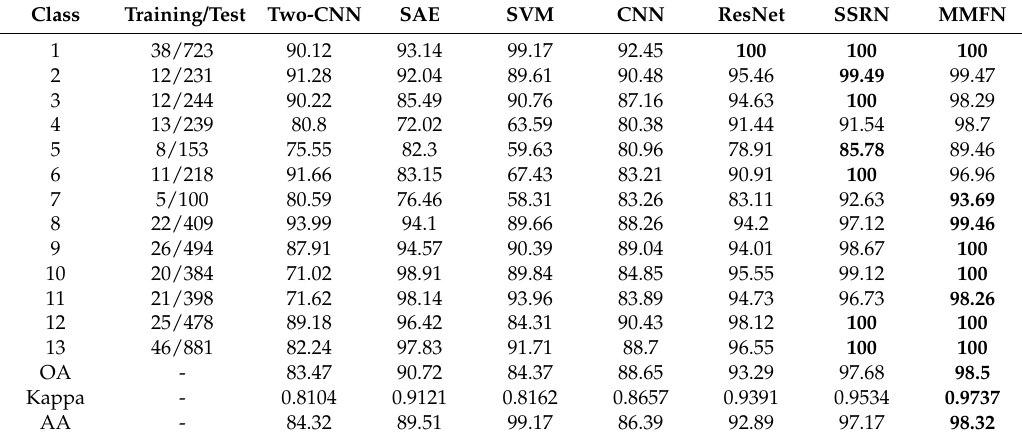
Table 11. Class-specific accuracies (%) of the KSC Data Set.